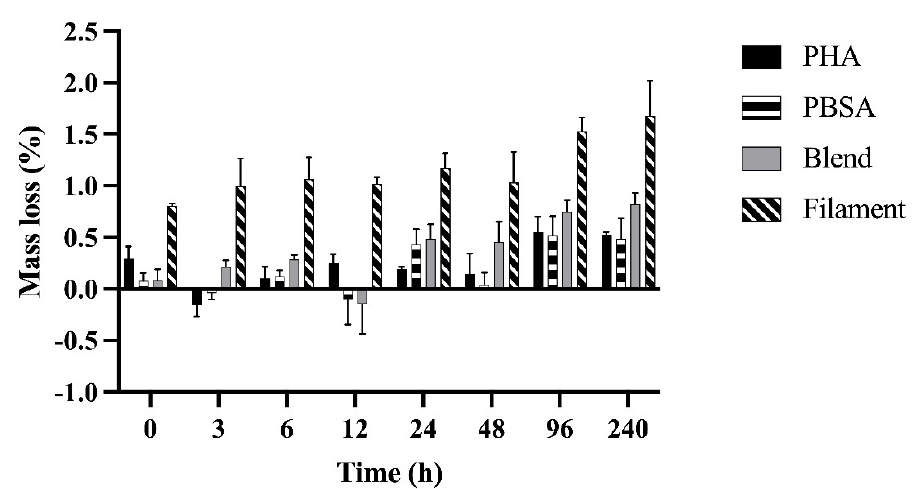
Figure 1. Mass loss (%) of polyhydroxyalkanoate nurdle (PHA), poly(butylene succinate- co -adipate) nurdle (PBSA), PBSA:PHA melt blend nurdle (90%wt PBSA, 10%wt PHA) (Blend), and a PBSA:PHA melt blend (90%wt PBSA, 10%wt PHA) filament (Filament) fermented in rumen fluid for up to 240 h. When comparing nurdles, bag type and all its interactions, as well as the interaction of treatment and time, were not significant. Treatment: p = 0.10. Time: p < 0.0001. When comparing Blend and Filament treatments, bag type and all its interactions, as well as the interaction of treatment and time, were not significant. Treatment: p < 0.0001. Time: p = 0.04. Data shown are least squared means of polymers in F57 and R510 bags in duplicate (LSM ± SEM).